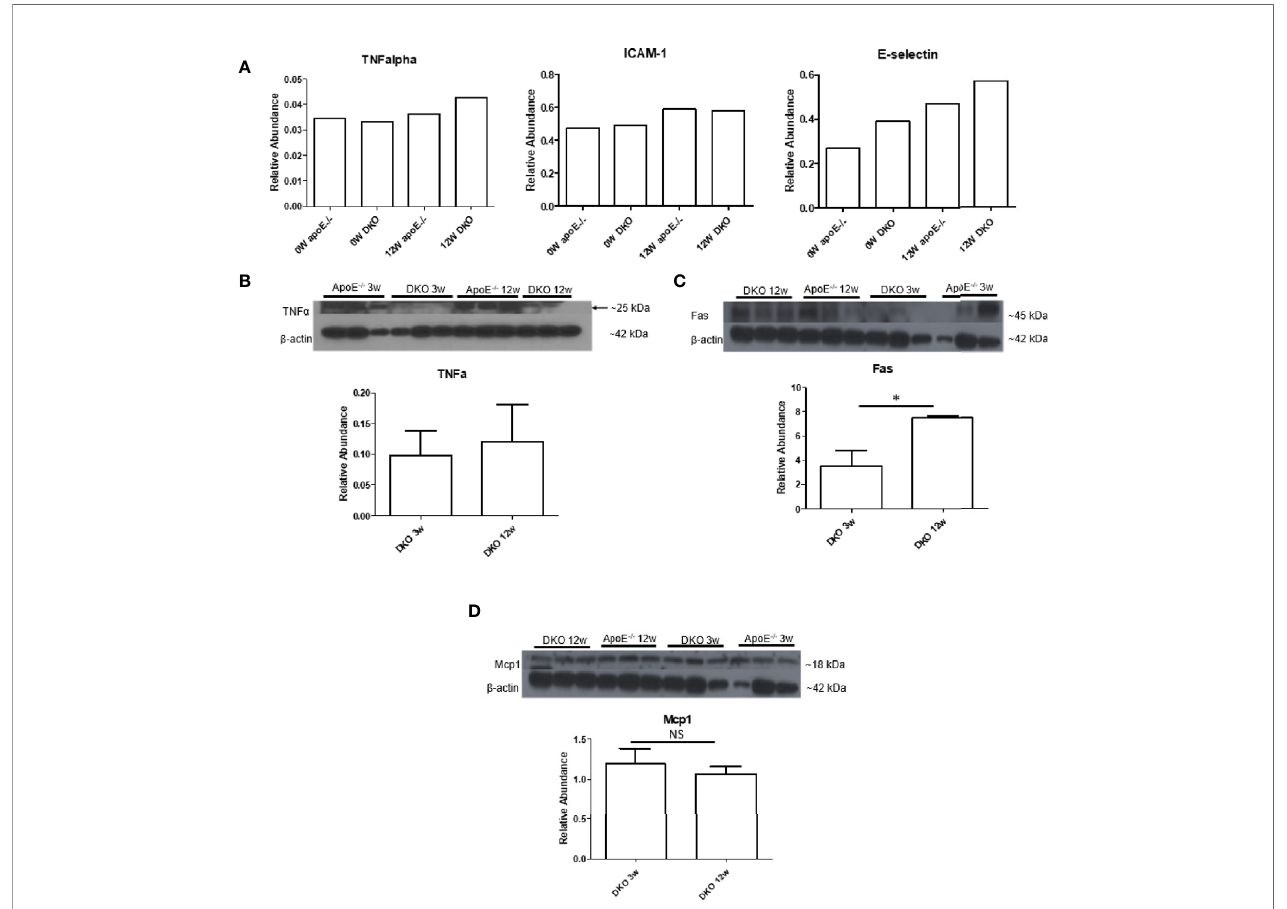
FIGURE 3 | Pro-in fl ammatory tumor necrosis factor-a (TNFa) and Fas are increased while leptin and Mcp1 show no change. (A) 0W: 8-week old male mice on normal chow (NC). 12W: 20-week old male mice that began HFD at 8 weeks old and continued for 12 weeks; n=3 per sample. Each group is composed of samples from 3 mice combined into 1 sample for analysis. (B – D) 3W: 11-week old male mice that began HFD at 8 weeks old and continued for 3 weeks. 12W: 20-week old male mice that began HFD at 8 weeks old and continued for 12 weeks; n=3 per group. * p <0.05. NS, not signi fi